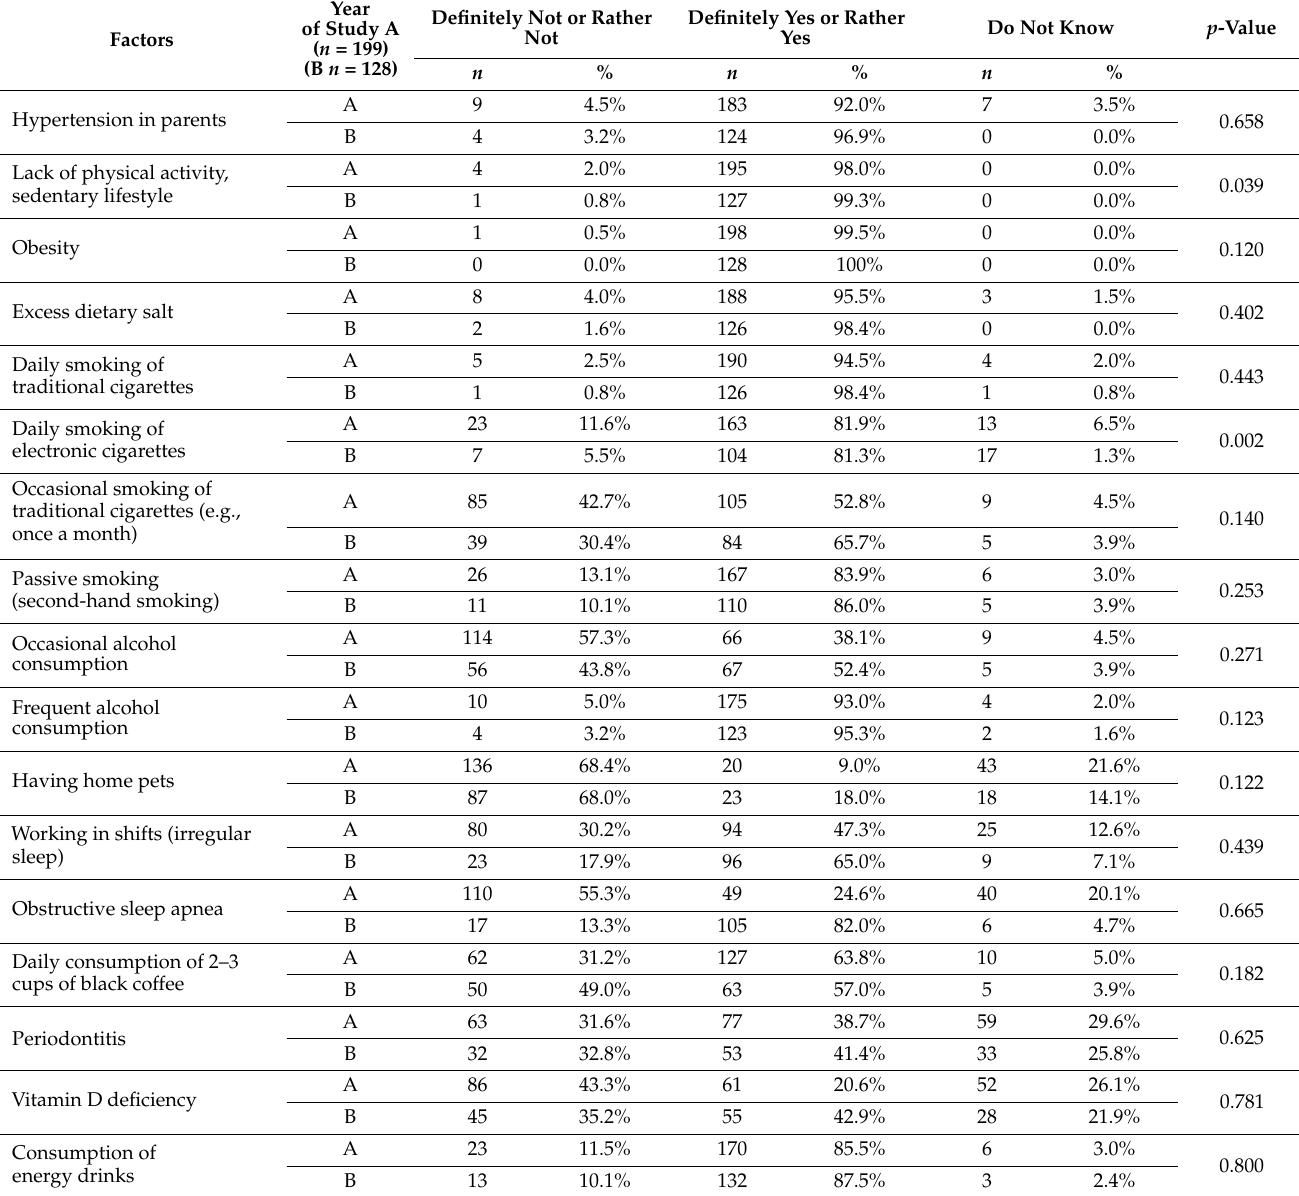
Table 3. Assessing the impact of potential risk factors that cause hypertension ( n =